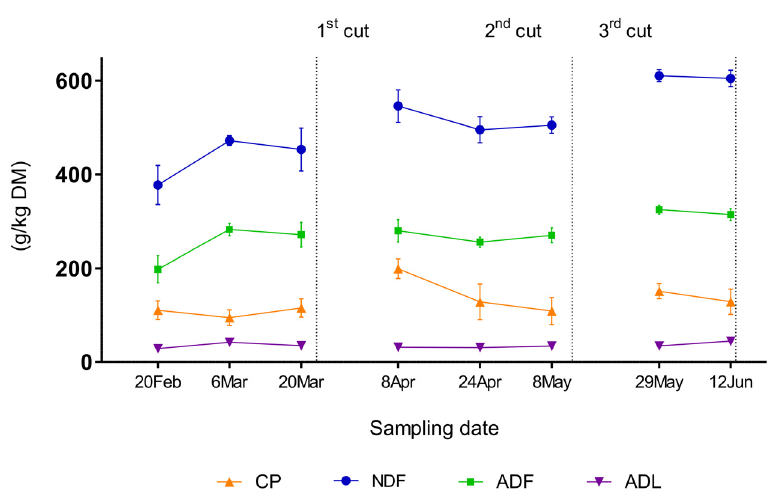
Figure 5. Changes in chemical composition during the crop growth cycle. All values are expressed as mean ± SD on a DM basis. CP—crude protein; NDF—neutral detergent fiber; ADF—acid detergent fiber; ADL—acid detergent lignin.